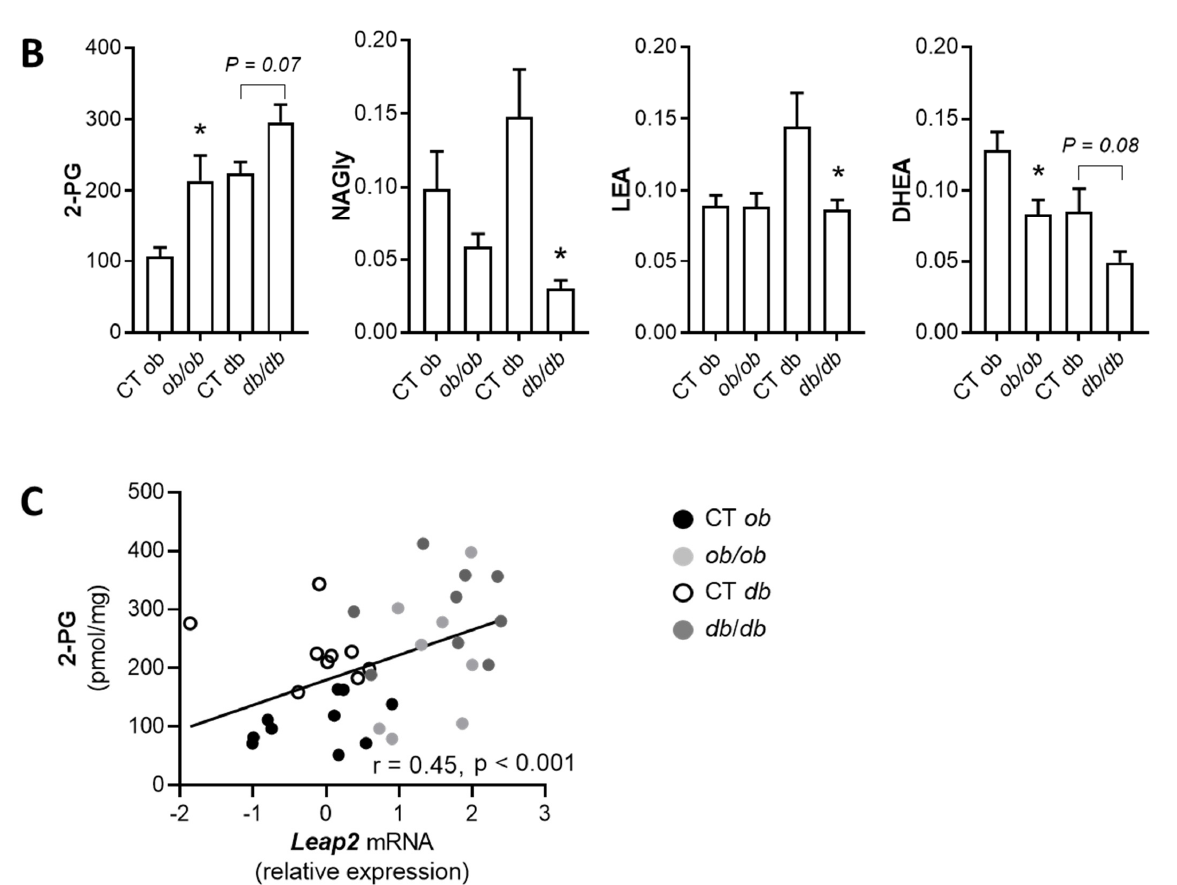
Figure 8. mRNA expression ( A ) in the liver, duodenum, jejunum, and ileum of ob / ob and db / db mice as measured by qPCR. Relative mRNA expression is represented as mean ± S.D. Values were compared relative to control (i.e., CT ob ; CT db ) mice for each tissue. Levels of select eCBome mediators within the ileum of ob / ob and db / db mice and their respective controls (( B ); pmol/mg wet tissue weight; 2-palmitoylglycerol; 2-PG, N -Arachidonoyl-glycine; NAGly; N -linoleoylethanolamine; LEA, N -docosahexaenoylethanolamine; DHEA), as measured by HPLC-MS/MS. Data are presented as the mean ± S.E.M. of n = 8–10 and were analyzed by one-way ANOVA followed by Tukey’s post hoc test. * p ≤ 0.05 vs. the respective control. ( B ). Pearson correlation analysis between the mRNA expression of Leap2 and the concentration of 2-PG both measured/quantified in the ileum of ob/ob and db/db mice, and their respective controls ( C ). n = 8–10